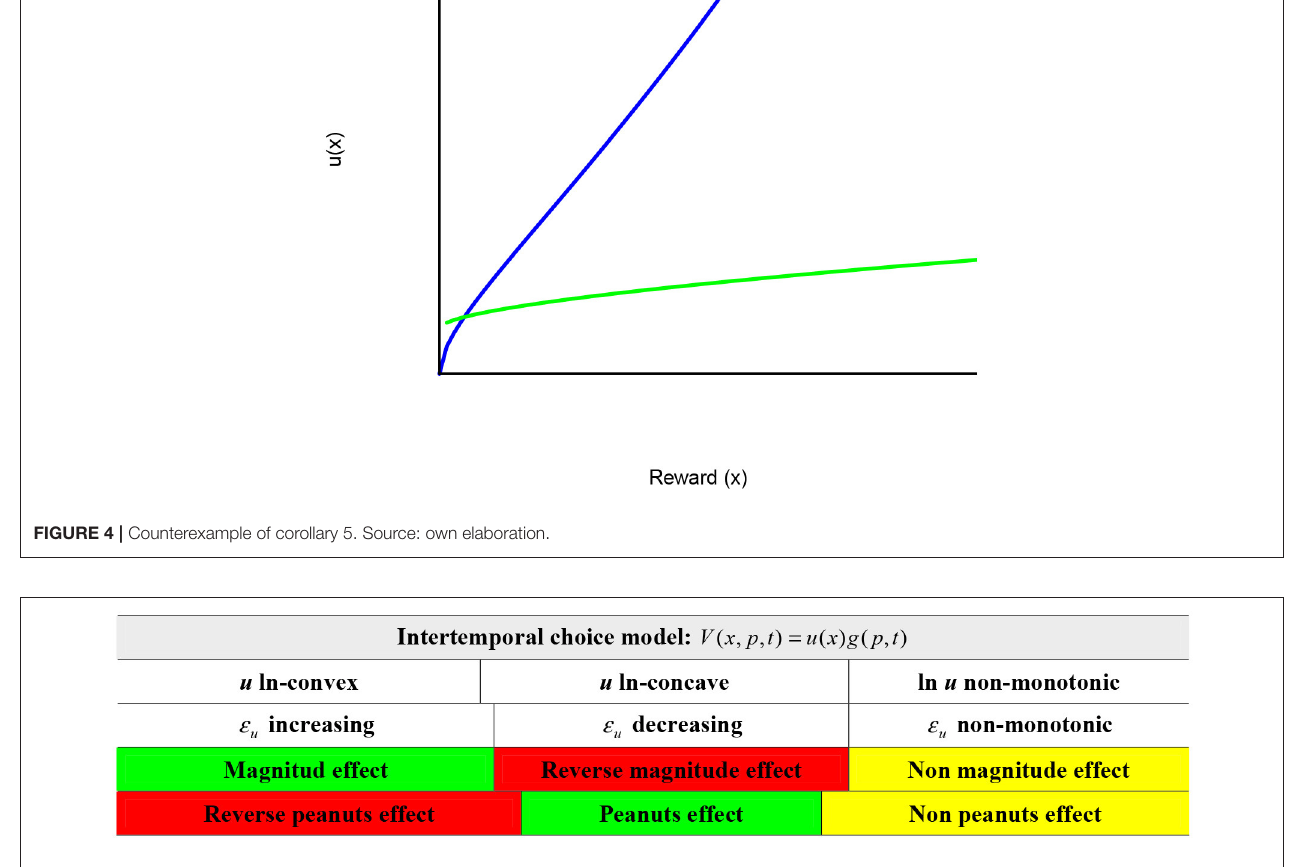
FIGURE 5 | Convexity, and peanuts and magnitude effects Green denotes de presence of the mentioned effect. Yellow denotes de absence of the indicated effect. Red represents the existence of the reverse of the mentioned effect. Source: own elaboration.